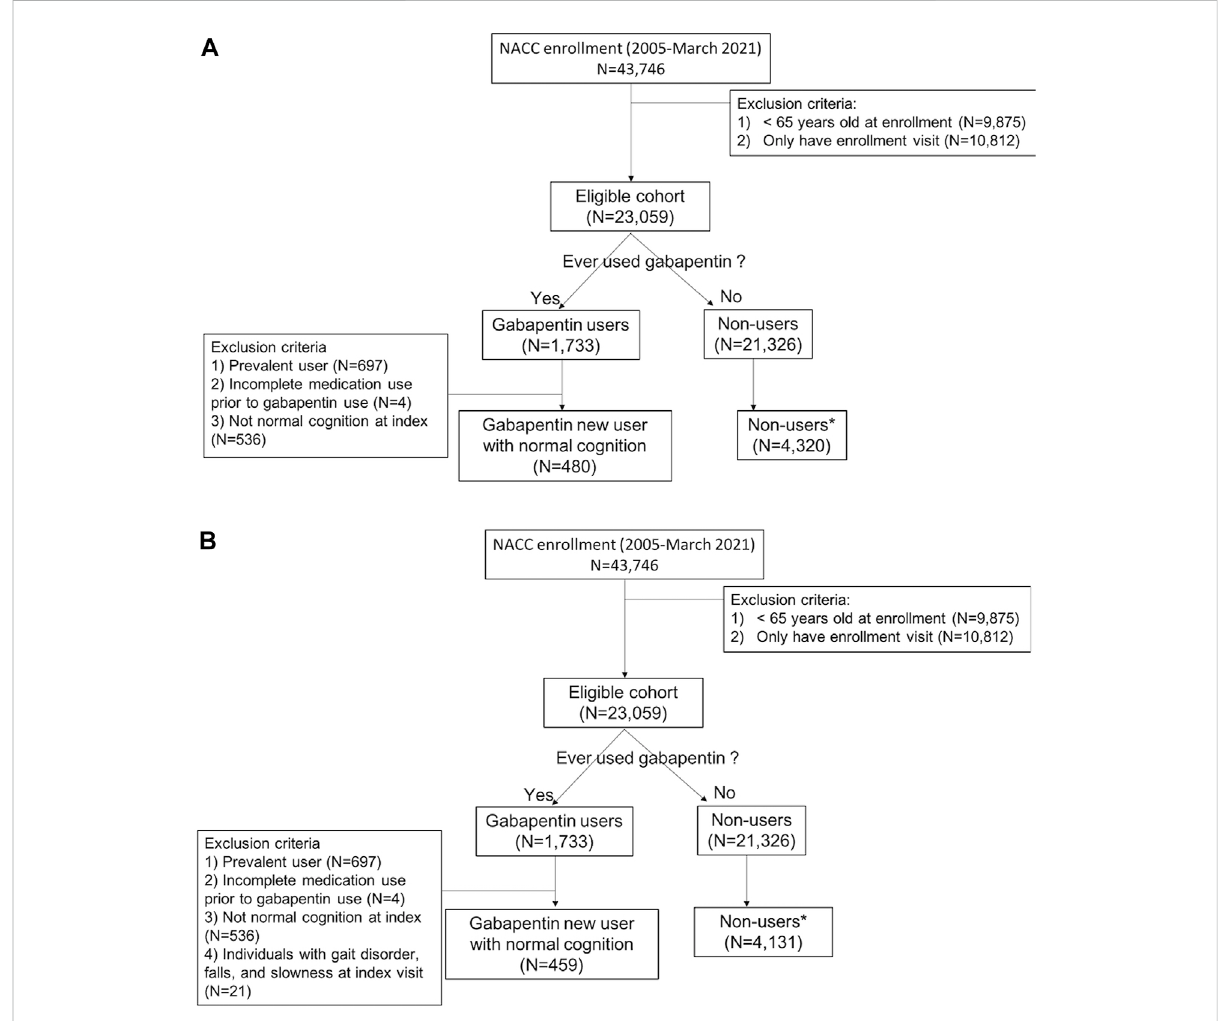
FIGURE 1 Flow diagram of inclusion and exclusion criteria (A) for measuring cognitive and functional status decline and (B) for measuring motor function change*1 to 9 randomly selected matched by year of fi rst enrollment and visit number to gabapentin initiation from the